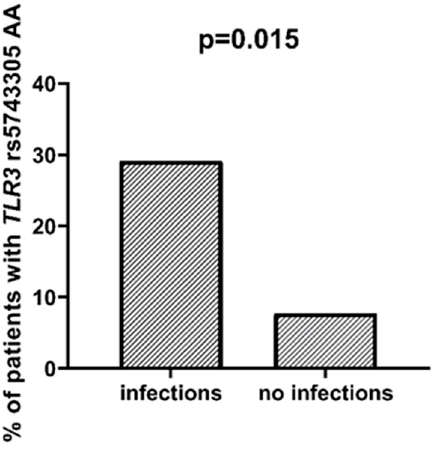
Figure 4. Association between TLR3 rs5743305 AA and incidence of infection.